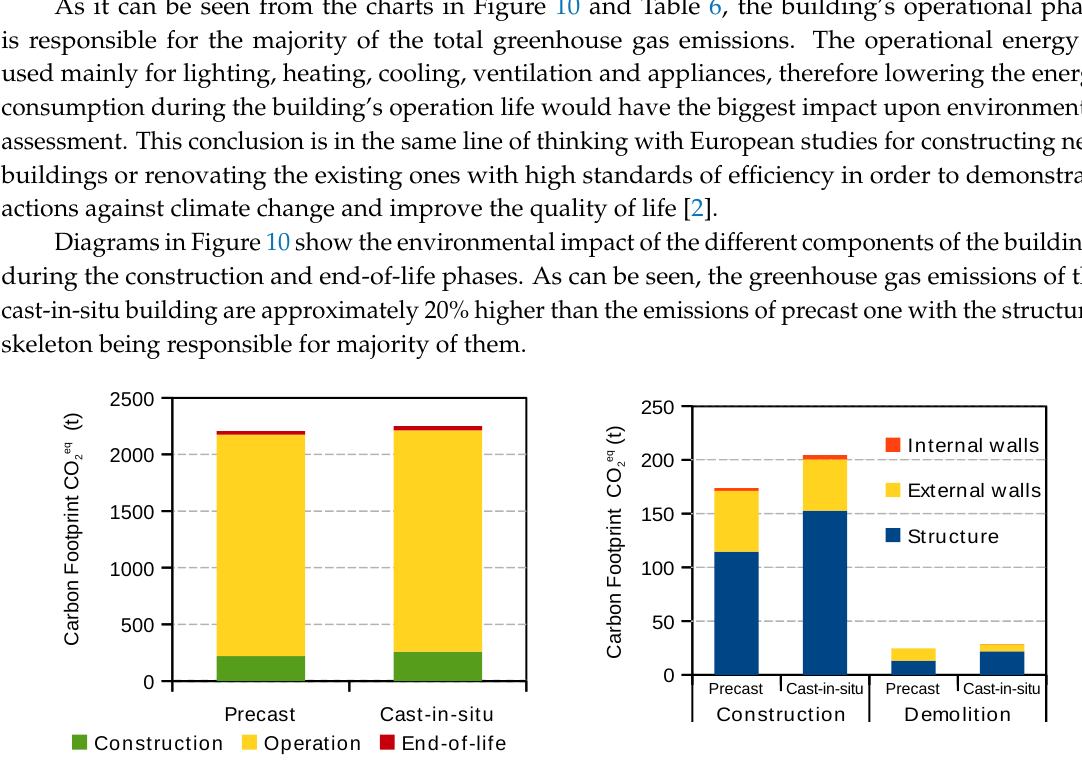
Figure 10. Emissions of the two buildings during the Life Cycle. Table 6. Carbon footprint after complete life cycle: Total and results per functional unit